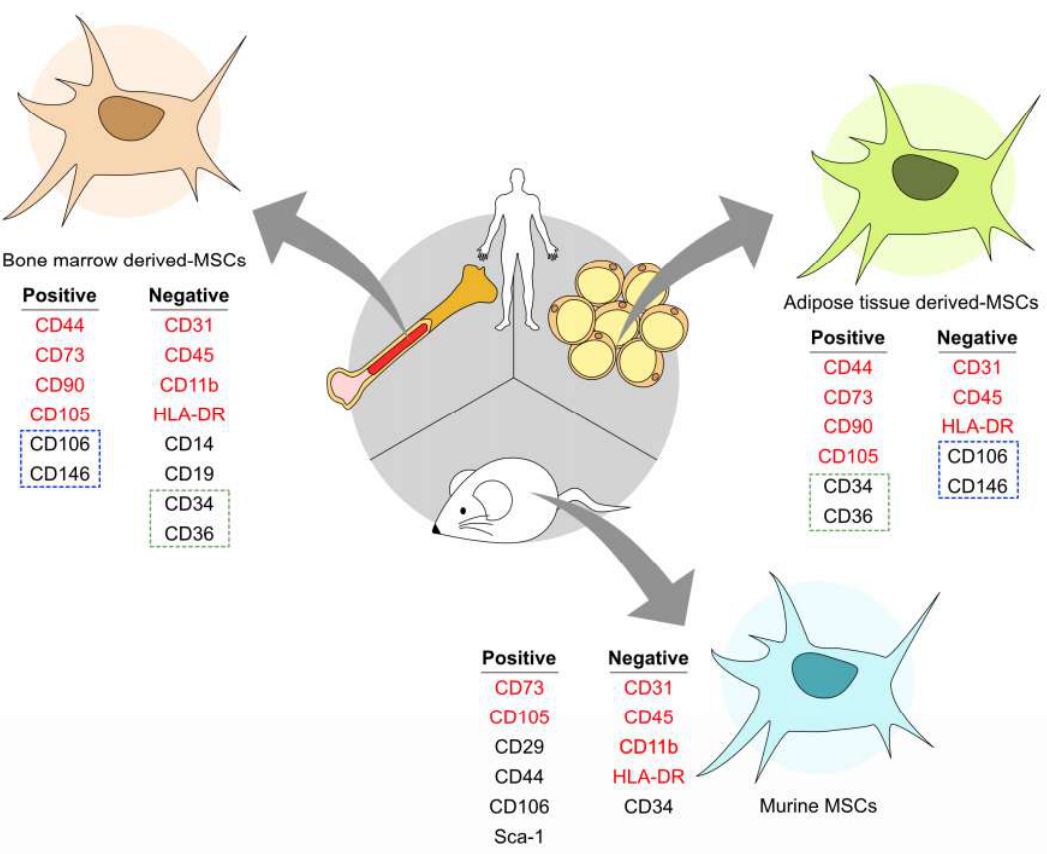
Figure 1. Cell surface markers of vary between mesenchymal stem cells / multipotent stromal cells (MSCs). Human bone marrow-derived (BM)-MSCs share most of the markers such as CD44, CD73, CD90, and CD105 with adipose-derived (AD)-MSCs. CD106 and CD146 (outlined with the blue dotted line) are positive in BM-MSCs, but negative in AD-MSCs. Both are negative with CD31, CD45, and HLA-DR, whereas BM-MSCs are negative with CD34 and CD36 (outlined with the green dotted line), which are positive in AD-MSCs. Mouse MSCs express Sca-1 specifically. The image was generated with Affinity Designer 1.6.1.